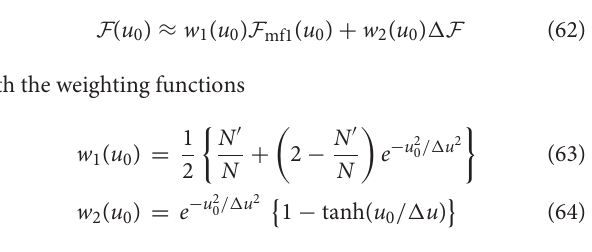
ln x ln ln x for x ≈ − ≫